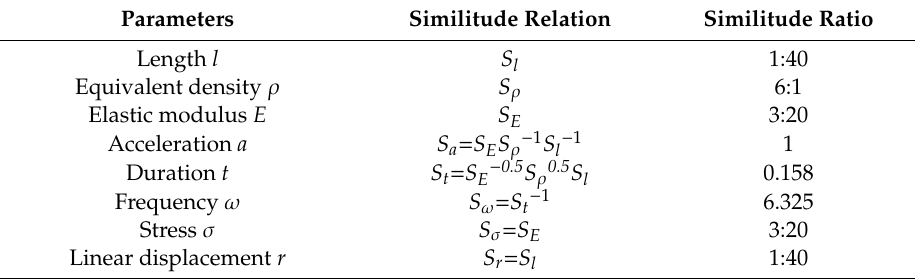
Table 1. Similitude laws of shaking table test.